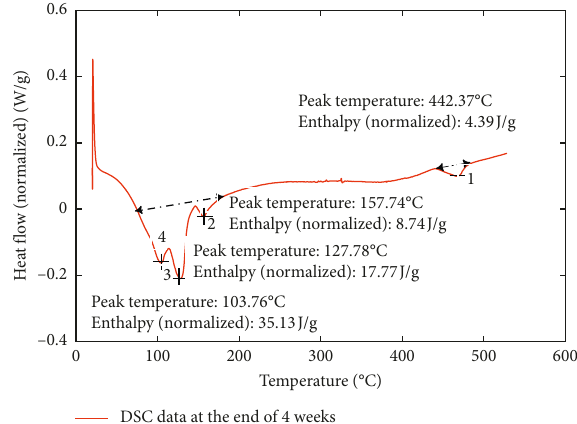
Figure 3: Typical DSC curve of specimens at the end of 4